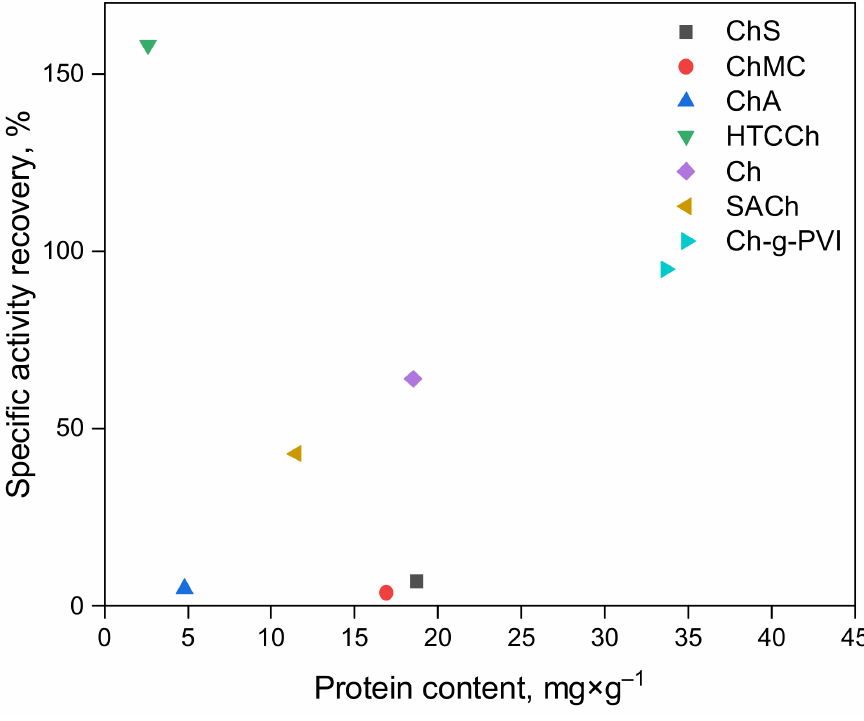
Figure 6. Comparison of specific activity recovery (%) of bromelain immobilized on different chitosan derivatives (values are given for derivatives with a molecular weight of 350